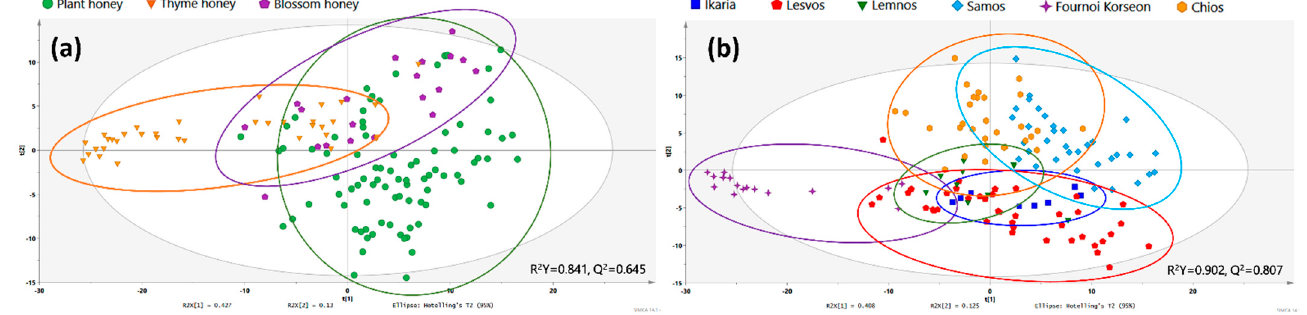
Figure 2. PLS-DA scores scatter plot of the dataset showing clustering based on ( a ) botanical and ( b ) geographical origin.